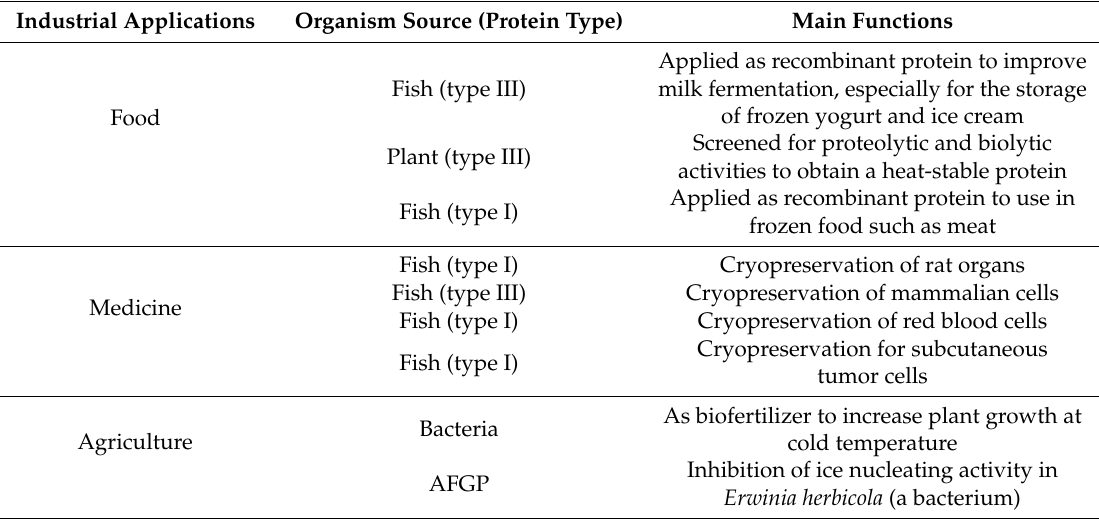
Applications of diverse antifreeze proteins, peptides / glycoprotein (AFGPs) from di ff erent